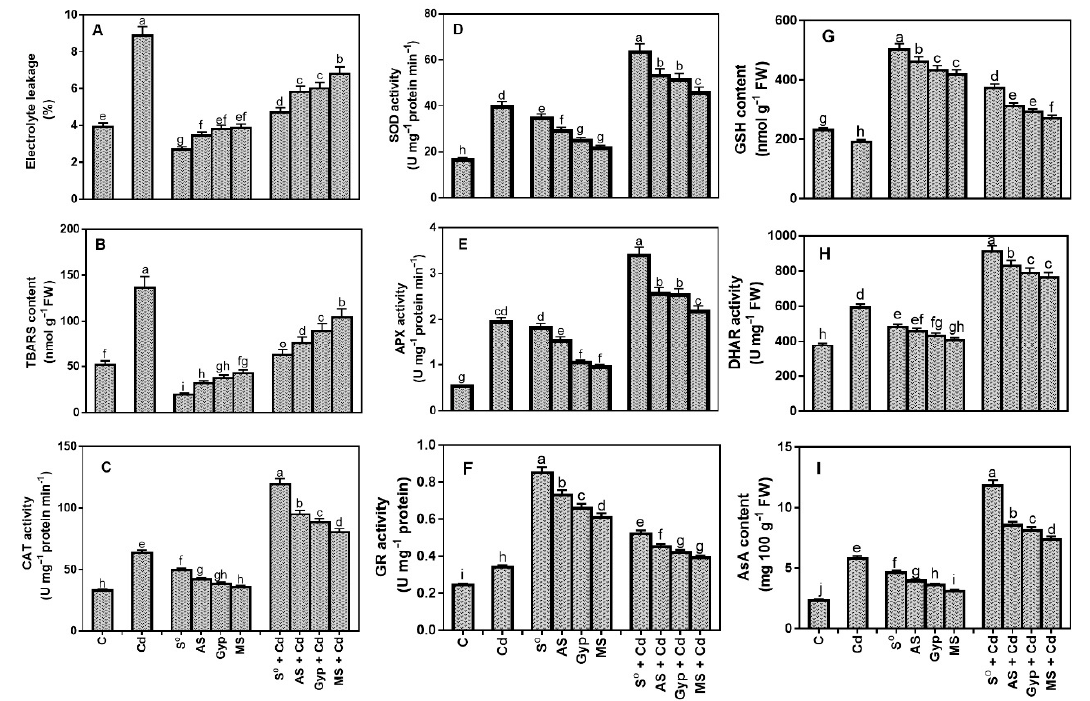
Figure 5. Foliar ( A ) Electrolyte leakage, ( B ) TBARS content, ( C ) CAT activity, ( D ) SOD activity, ( E ) APX activity, ( F ) GR activity, ( G ) GSH content, ( H ) DHAR activity, and ( I ) AsA content ( I ) in Brassica juncea cv. Giriraj treated with 200 mg S kg − 1 soil of elemental S (S 0 ), ammonium sulfate (AS), gypsum (Gyp) or magnesium sulfate (MS), grown with or without cadmium (200 mg Cd kg − 1 soil). Data are presented as means ± SE ( n = 4). Data with the same letter are not significantly different by LSD test at p < 0.05. APX, ascorbate peroxidase; AsA, ascorbate; C, control; CAT, catalase; Cd, cadmium; DHAR, dehydroascorbate reductase; FW, fresh weight; GR, glutathione reductase; GSH, reduced glutathione; SOD, superoxide dismutase; TBARS, thiobarbituric acid reactive substances.